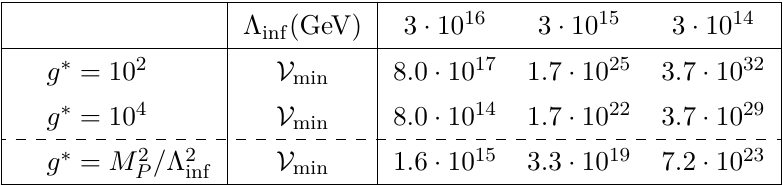
√ Table 1 . Lower bound for a stable volume (measured in units of (2 π α 0 ) 6 ) in LVS as a function of the inflation scale, assuming only a thermal de Sitter radiation bath. The first line conservatively assumes the number of relativistic degrees of freedom after inflation to be g ∗ = g SM ' 100 , while the second one uses the more aggressive estimate g ∗ = 10 4 . The third line gives an absolute lower bound assuming the maximum number of degrees of freedom compatible with the species